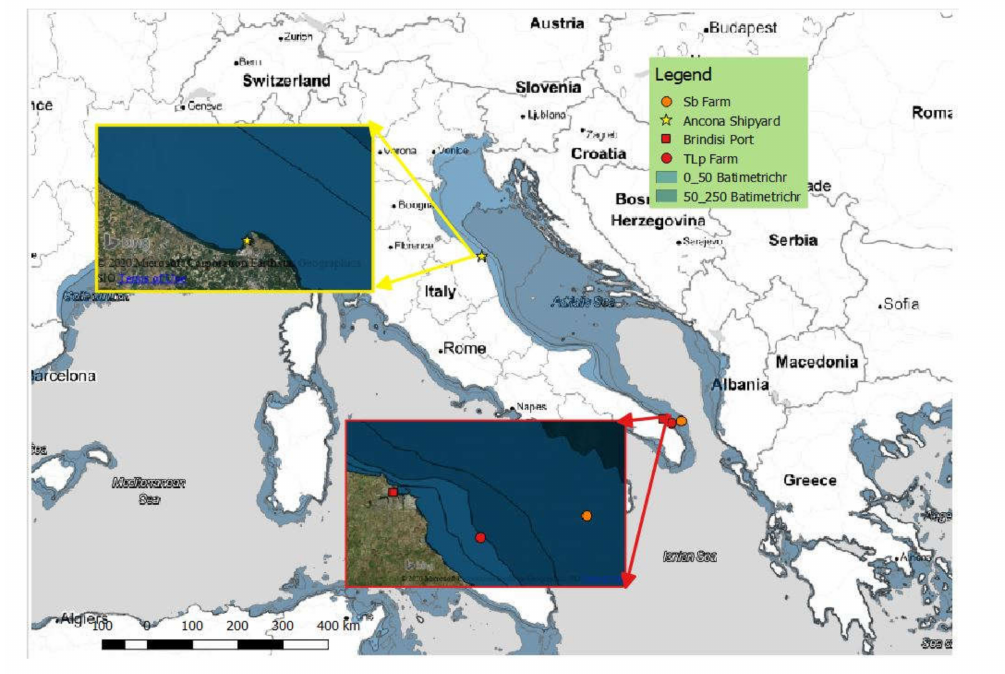
Figure 5. Case study